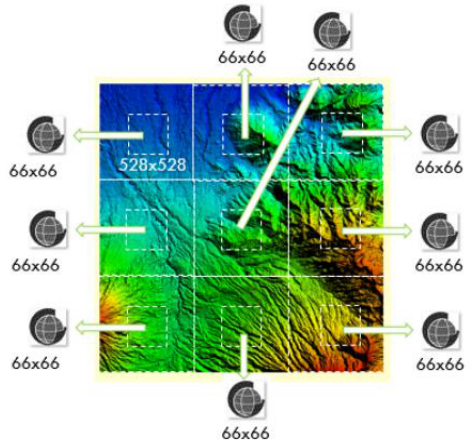
Figure 3. Watermarked DEM.